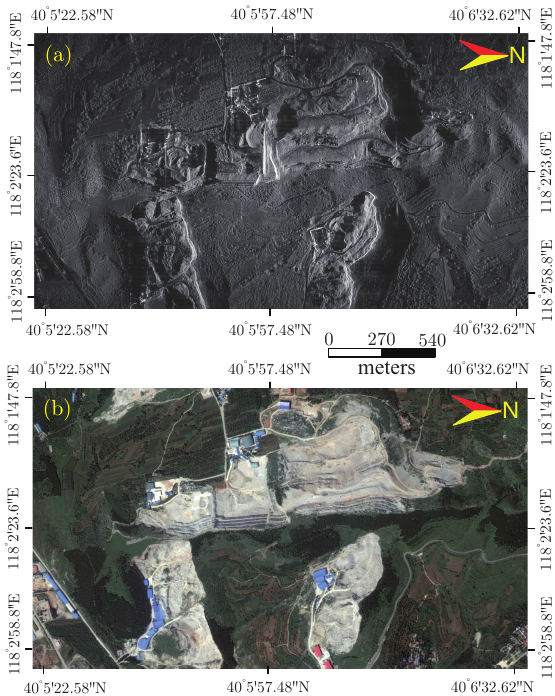
Figure 12. Monostatic spotlight image processed using MoBulk_FBP. ( a ) The monostatic spotlight image; ( b ) the optical image of the imaging area from Google